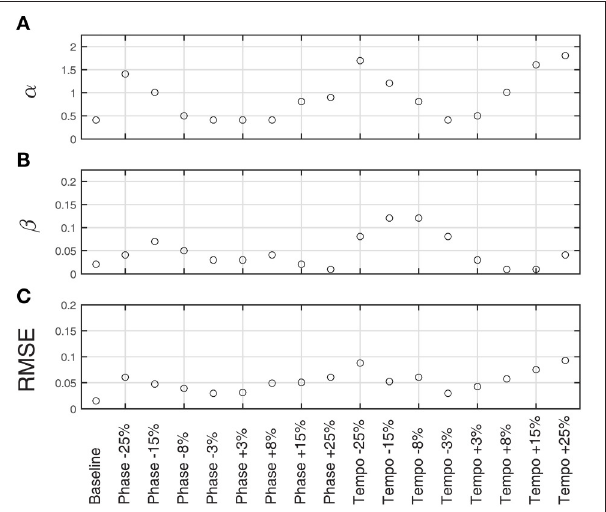
FIGURE 4 | Fitted model parameters and RMSE for averaged trials for each condition at 85 bpm ( n = 80 baseline trials, n = 10 perturbation trials per condition). α (A) represents the strength of phase coupling, or how strongly the stimulus affects the phase of the model’s behavior. β (B) represents the strength of the period coupling. On average, the magnitude of phase coupling was 20 times stronger than the magnitude of the period coupling, suggesting that Ronan is primarily using phase adaptation to match the stimulus. Also of note is that α is strongly affected by perturbation magnitude. RMSE (C) is the root mean squared error of the fitted model compared to Ronan’s